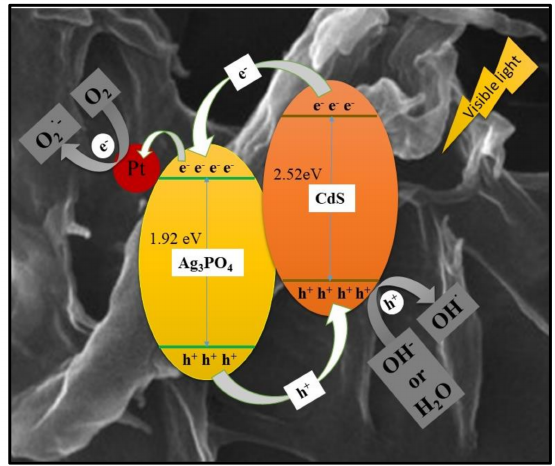
Figure 8. Proposed photocatalytic mechanism of Pt-Ag 3 PO 4 / CdS / chitosan under visible